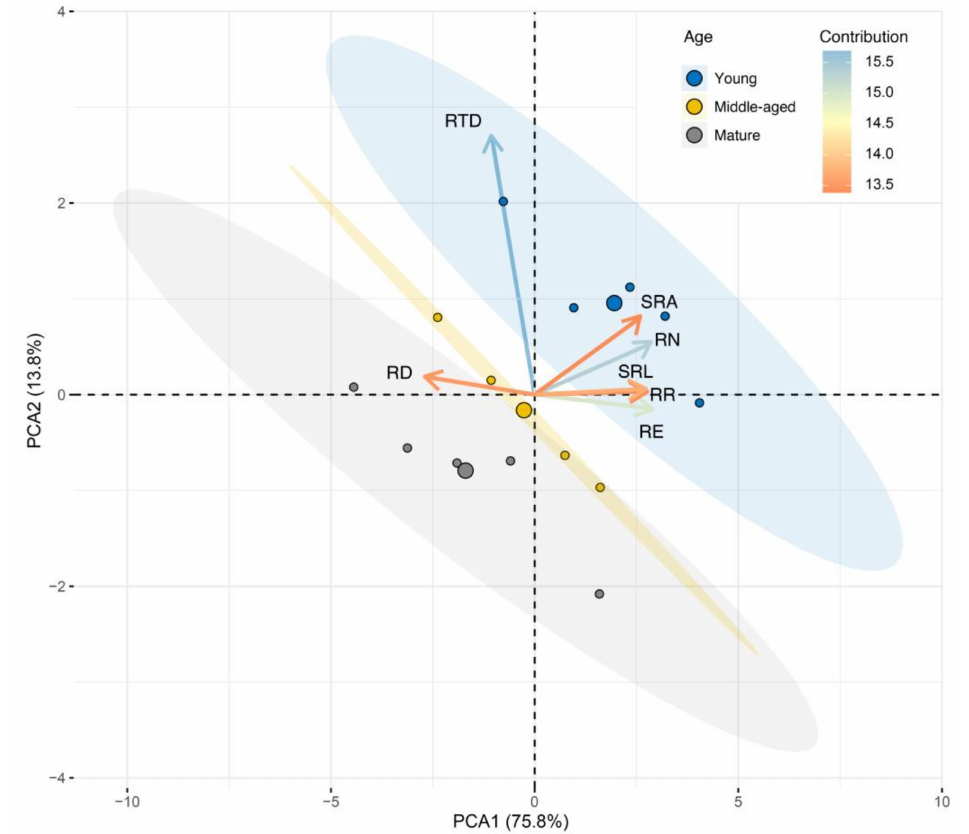
Figure 3. Principal component analysis (PCA) for root respiration rate (RR), root exudation rate (RE), root diameter (RD), root nitrogen concentration (RN), root tissue density (RTD), specific root length (SRL) and area (SRA) in Fraxinus mandshurica at different tree ages. Variables used for the PCA are shown with their